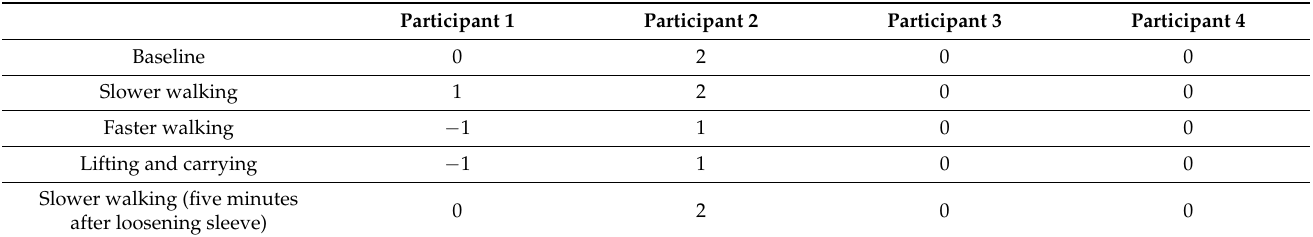
Table 3. Thermal Comfort results for each participant for the Form-Fitting Leg Sleeve, where − 3 represents very un- comfortable, − 2 slightly uncomfortable, − 1 uncomfortable, 0 neutral, 1 slightly comfortable, 2 comfortable, and 3 very comfortable.